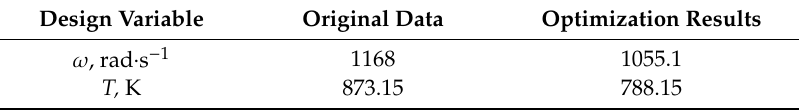
Table 6. Dynamic probabilistic computational results with different methods. FMERSM: fuzzy multi-extremum response surface method, MC: Monte Carlo.